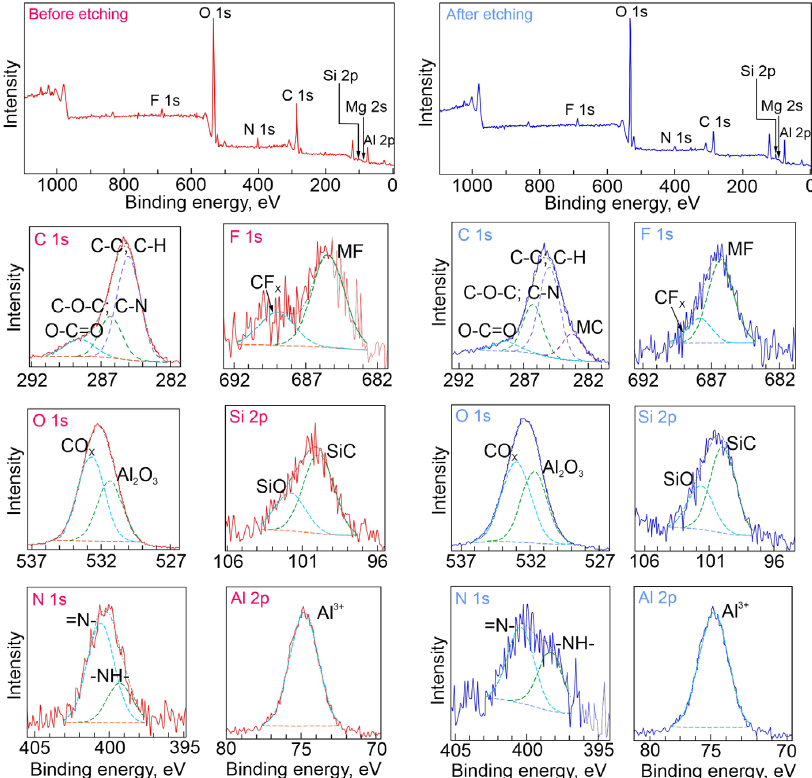
Figure 5. XPS spectra obtained for a sample with benzotriazole containing composite coating (0.05 M) and the detailed high resolution spectra before and after Ar + etching . Table 2. Binding energy (eV) and elemental composition (at. % in parentheses) of the surface of CC - btr - 24 sample .